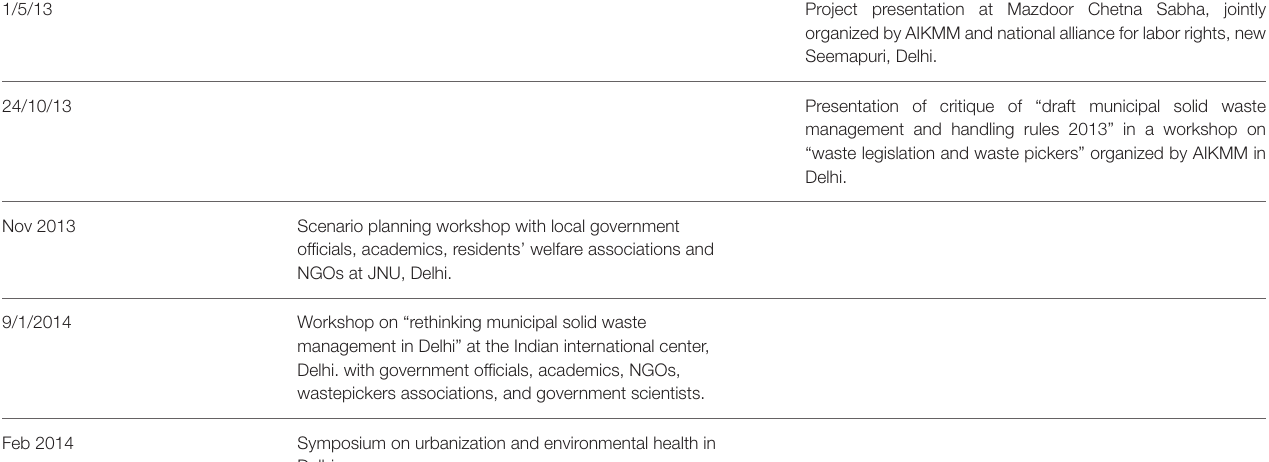
Drawing on historical gray and academic literature, Figure